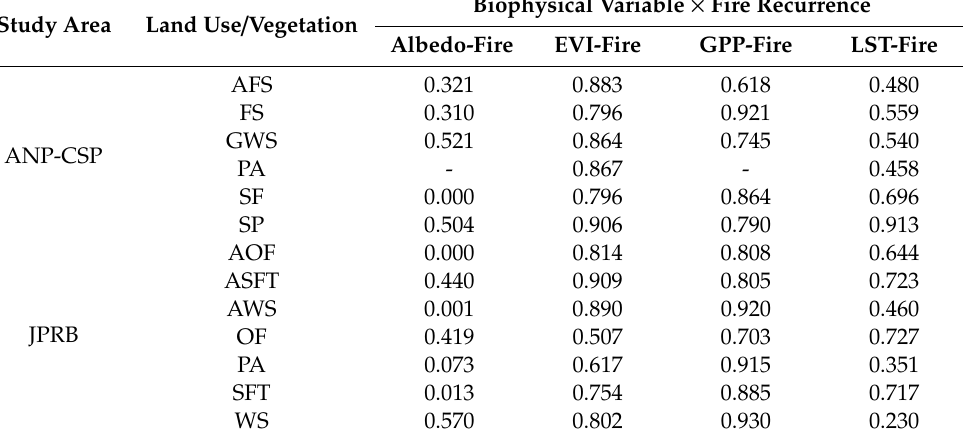
Table 4. R 2 values by land use / vegetation types for the relationships between MODIS biophysical variables and fire recurrence. The classes in the JPRB area were: Altered Ombrophilous Forest (AOF), Altered Savanna / Forest Transition (ASFT), Altered Woody Savanna (AWS), Ombrophilous Forest (OF), Pasture / Livestock (PA), Savanna / Forest Transition (SFT), and Woody Savanna (WS). In the ANP-CSP, the classes were: Altered Forested Savanna (AFS), Forested Savanna (FS), Grassy-woody Savanna (GWS), Pasture / Livestock (PA), Seasonal Forest (SF) and Savanna Parkland (SP). Biophysical Variable × Fire Recurrence Study Area Land Use / Vegetation Albedo-Fire